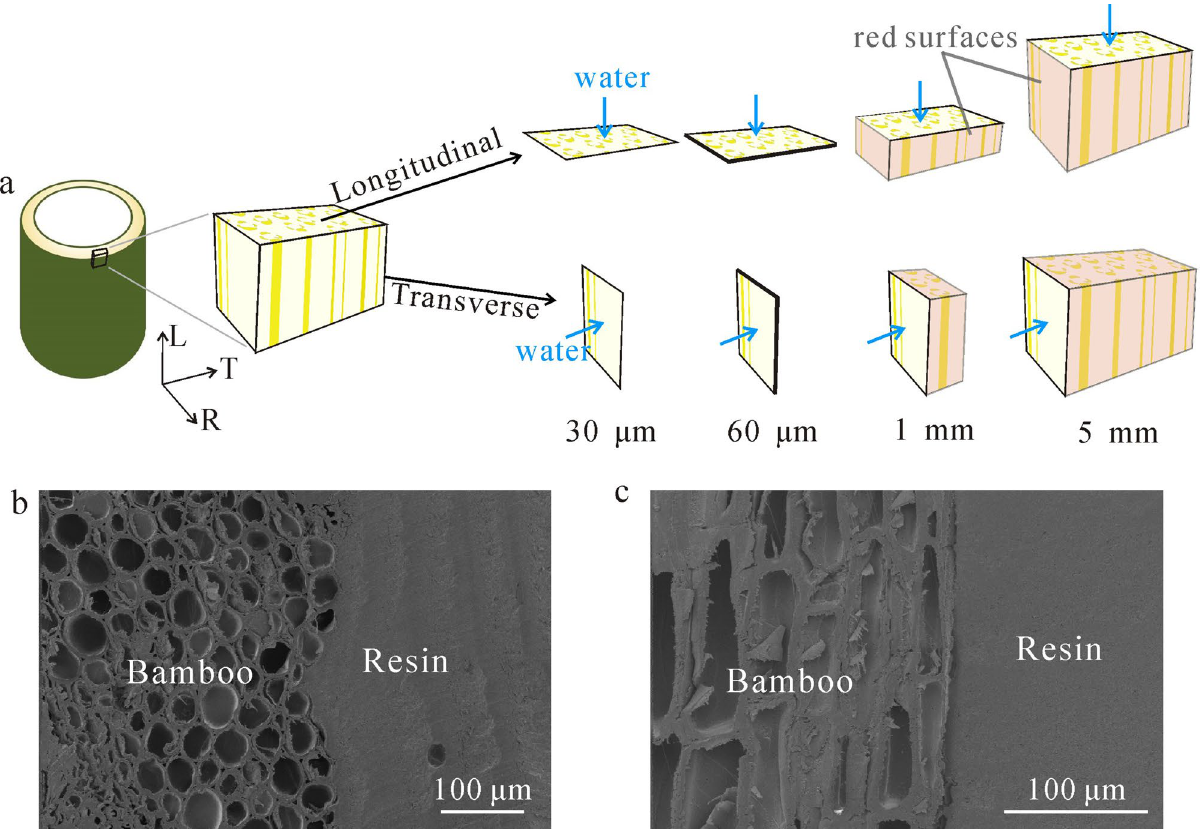
Figure 1. ( a ) Schematic of specimens with longitudinal and transverse sorption direction, where the blue arrows represent moisture sorption directions and red surfaces represent the surfaces that were covered by epoxy resin. ( b ) SEM picture of L specimen with resin edge sealing, ( c ) SEM picture of T specimen with resin edge